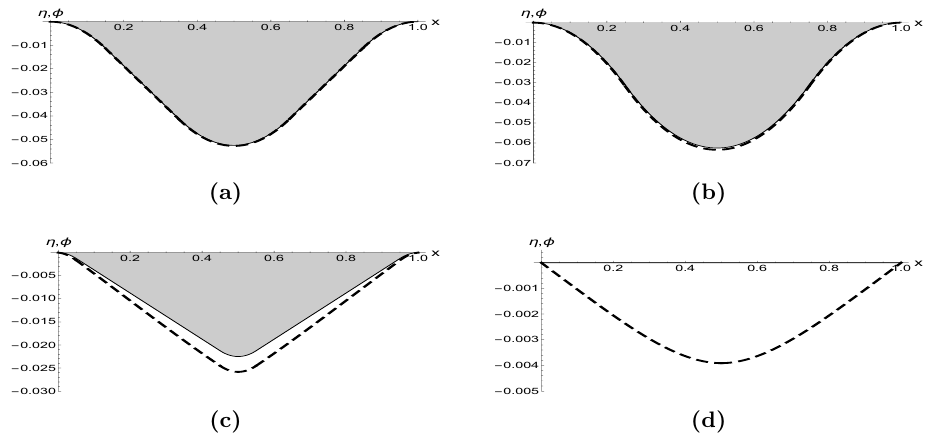
Figure 13. The exact breather (cid:30) ( t; x ) in the signum-Gordon model (shadowed region) and the approximated oscillon solution (cid:17) ( t; x ) (dashed line) in the perturbed model with l = 1. The (cid:12)gures correspond to (a) t = 0 : 15, (b) t = 0 : 25, (c) t = 0 : 45, (d) t = 0 : 5.